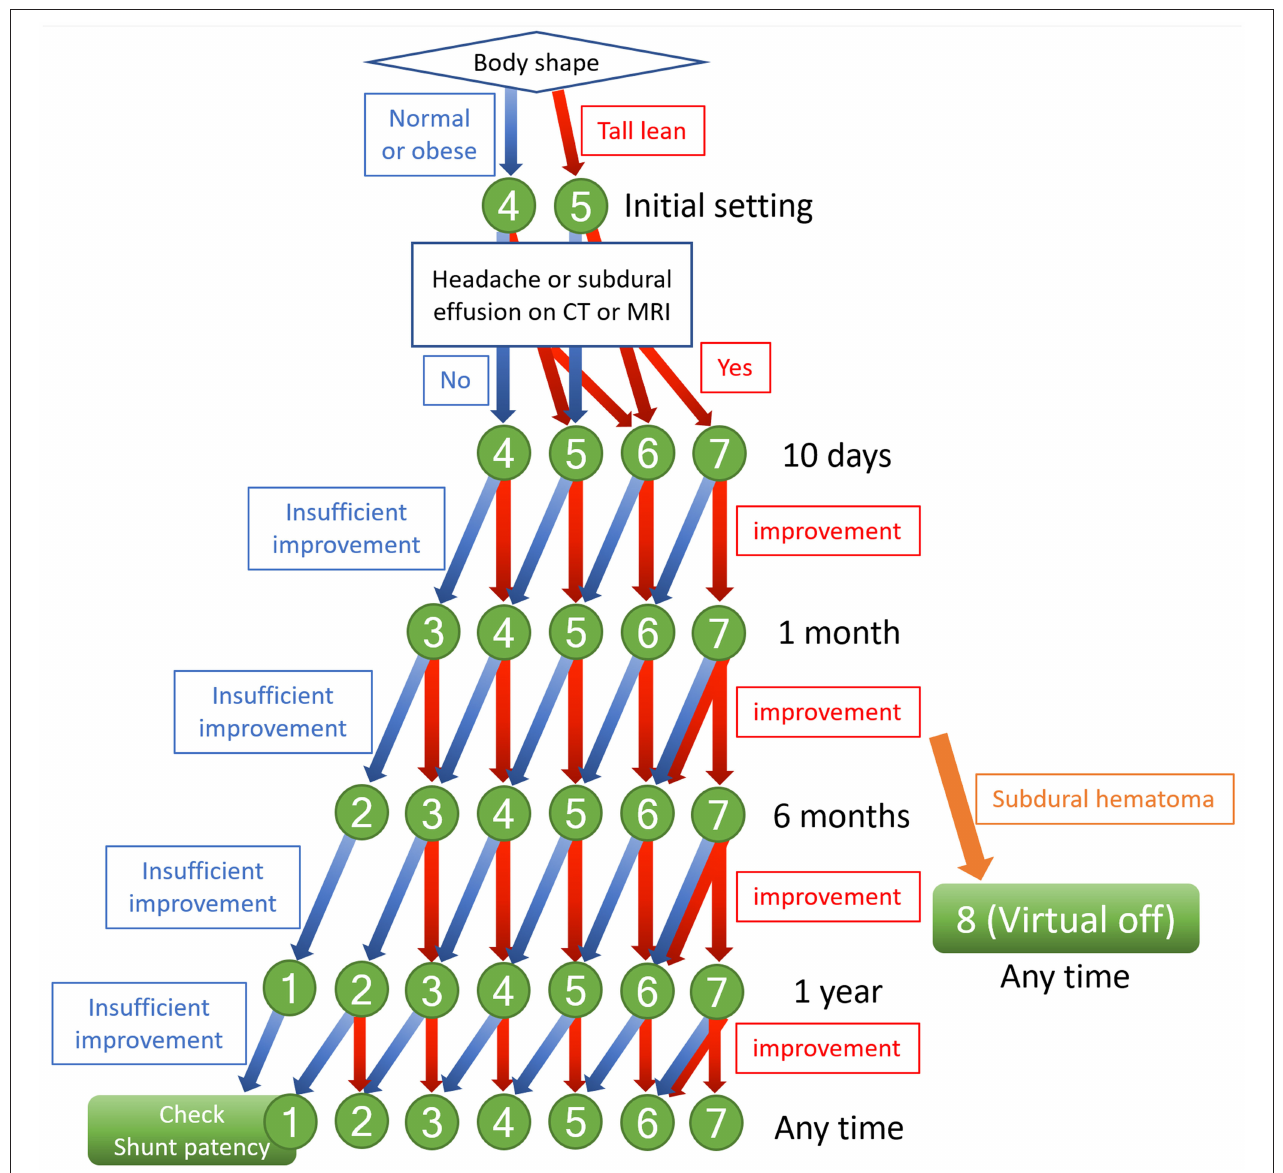
FIGURE 6 | Flowchart of indicators to change shunt valve pressure. The numbers indicate the pressure setting of the CERTAS Plus Programmable Valve. Setting 1: 25 ± 20 mmH2O, setting 2: 50 ± 20 mmH2O, setting 3: 80 ± 20 mmH2O, setting 4: 110 ± 25 mmH2O, setting 5: 145 ± 35 mmH2O, setting 6: 180 ± 35 mmH2O, setting 7: 215 ± 35 mmH2O, and setting 8: above 400